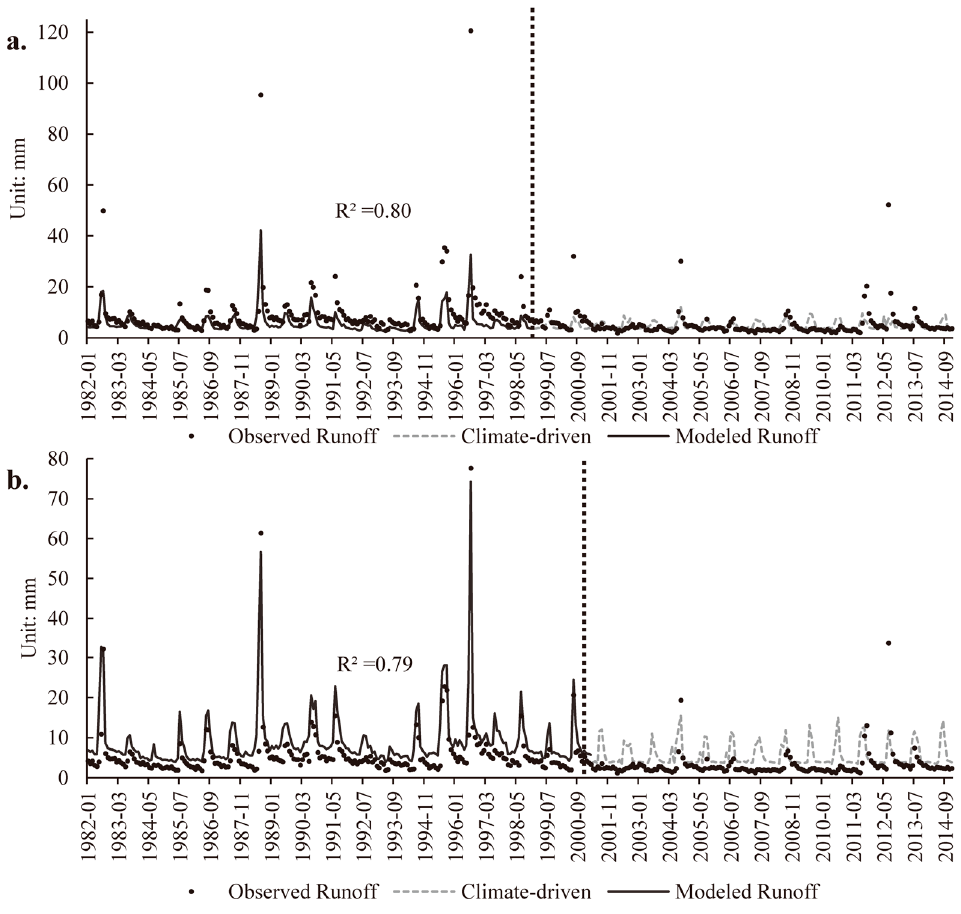
Figure 5. The results of modeled VS observed runoff in the Daomaguan basin ( a ) and the Zijinguan basin ( b ).